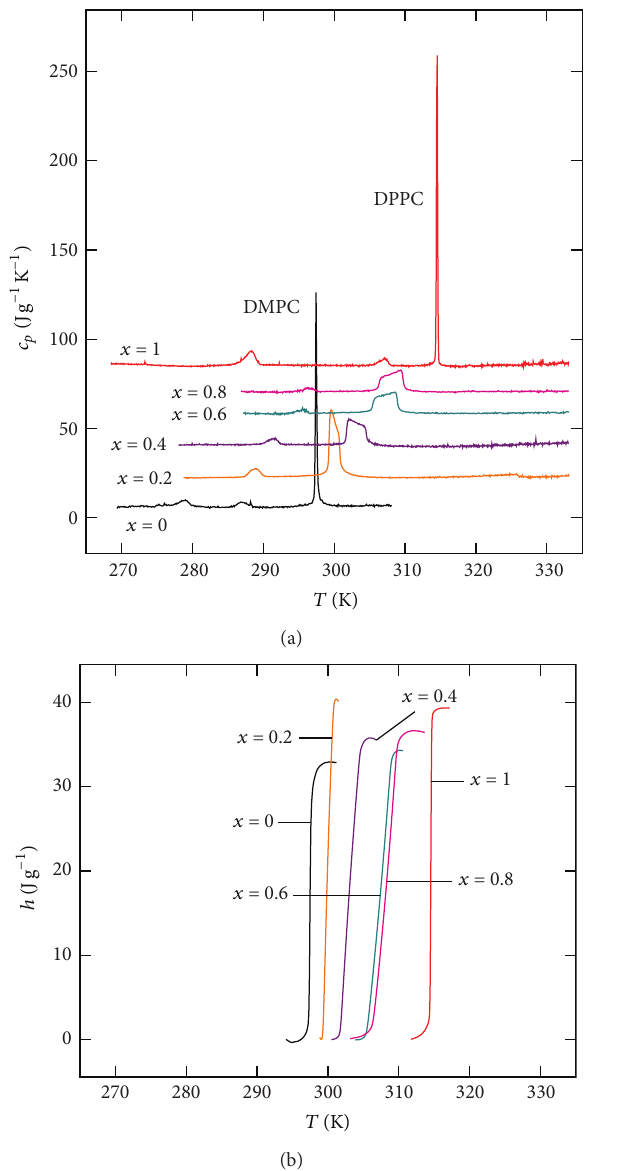
Figure 6: (a) Specific heat capacity 𝑐 𝑝 (𝑇) of the lipids in 10mgmL −1 dispersions of DMPC + DSPC mixtures over the complete concen- tration interval. (b) ℎ(𝑇) discontinuities at the main phase transition temperature for the mixtures displayed. The 𝑐 𝑝 values have been shifted for better display; 𝑥 refers to the mole fraction of DSPC in the lipid